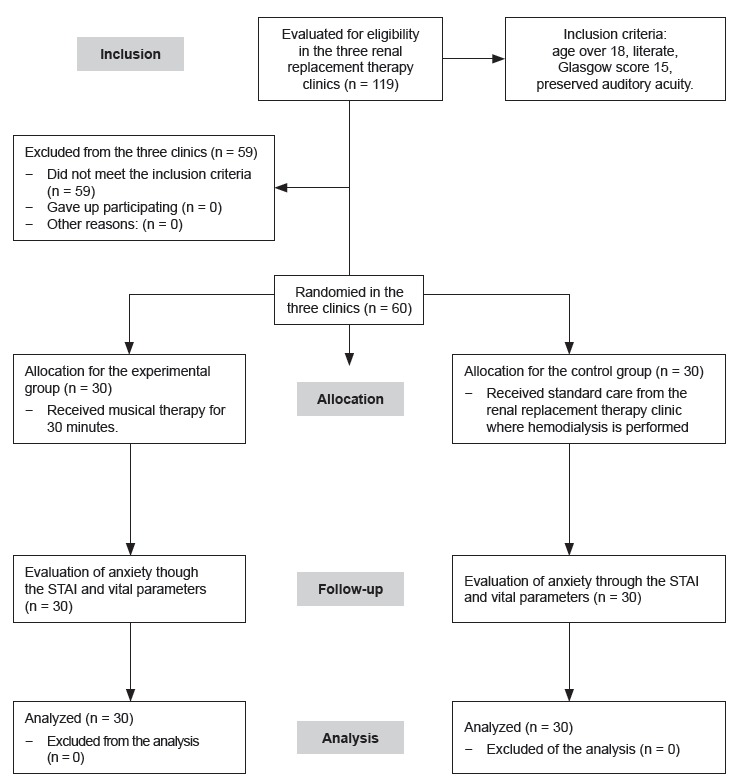
Flowchart of the study. Cajazeiras, Guarabira, Patos; Paraíba; Brazil,
2016